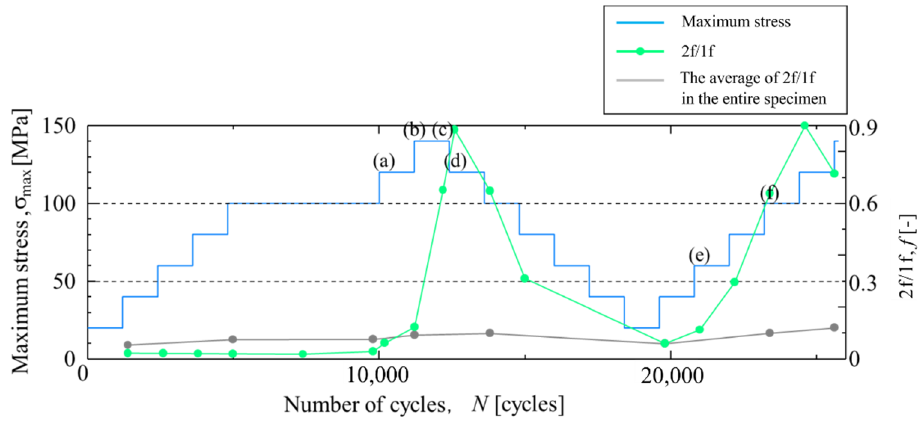
Figure 17. Change in temperature and load signal in Area c-3 measured at ( a ) σ max = 120 MPa and N = 10,200 cycles, ( b ) σ max = 140 MPa and N = 11,200 cycles, ( c ) σ max = 140 MPa and N = 12,200 cy- cles, ( d ) σ max = 120 MPa and N = 12,600 cycles, ( e ) σ max = 60 MPa and N = 21,000 cycles and ( f ) σ max = 100 MPa and N = 23,400 cycles.